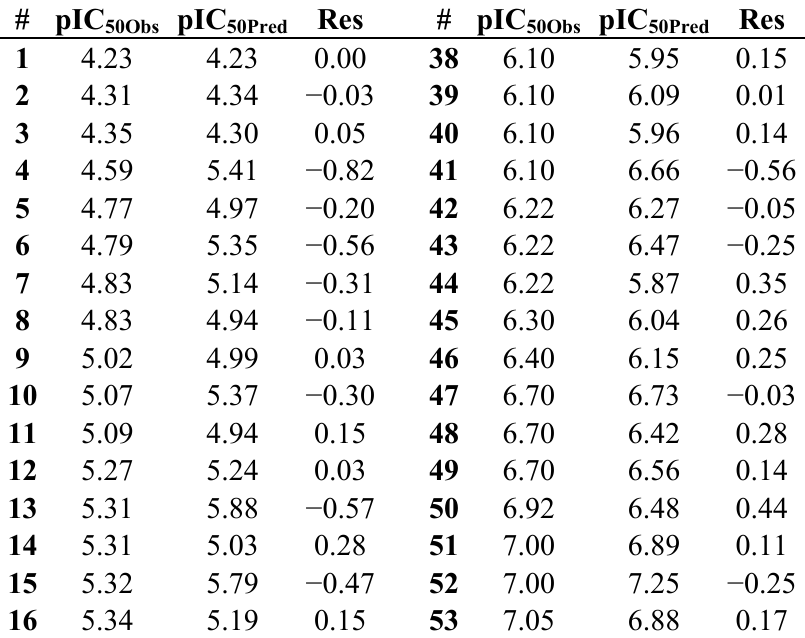
Table 6. Values of pIC the training ( 1 – 59 ) and test ( 60 – 74 ) sets according to the Eq.E (DB-I)